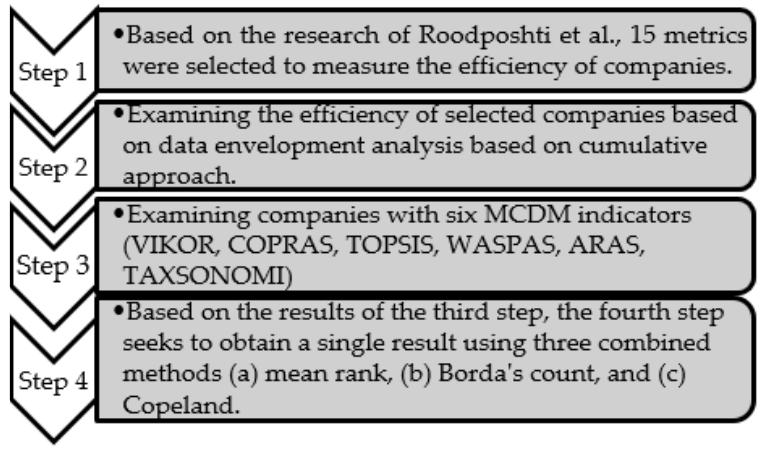
Figure 1. The research flow.